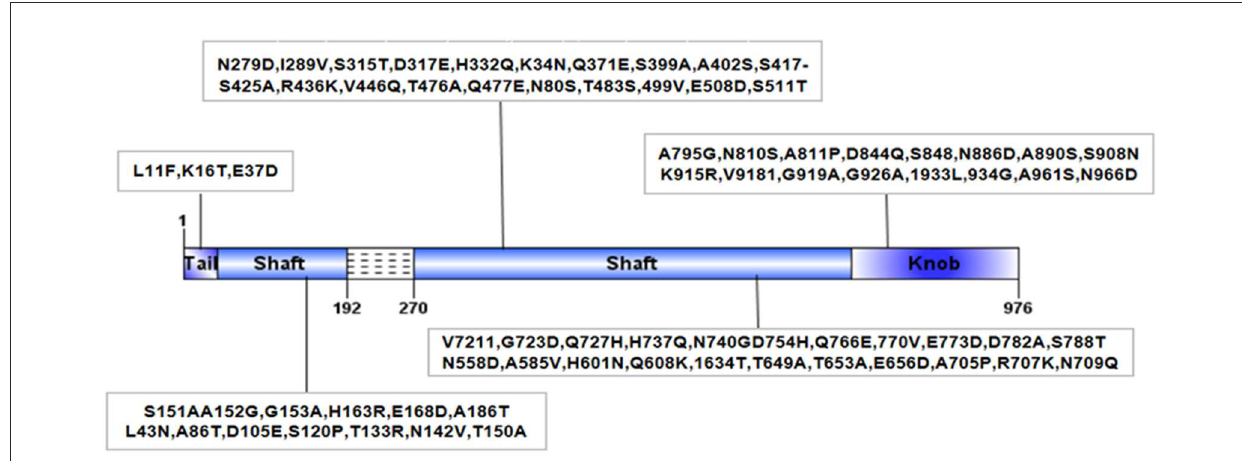
FIGURE1 Structural diagram of fiber protein of BO/YB24/17/CH strain. Dashed lines indicated amino acid deletion at position 192 ∼ 270 of BO/YB24/17/CH in shaft region. The black box indicated the unique amino acid mutation of BO/YB24/17/CH compared to all available complete 9 BAdV-3 fiber